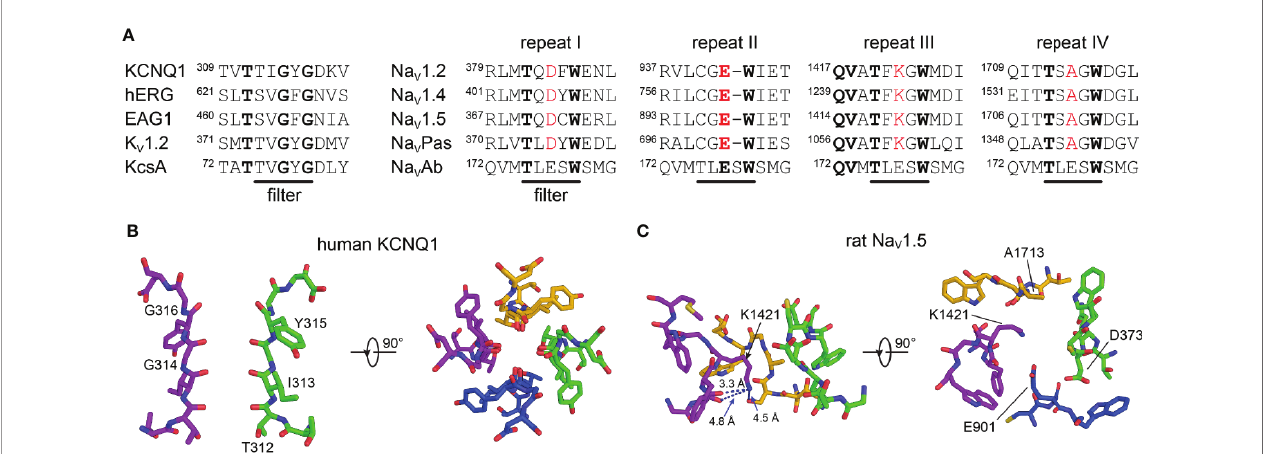
FIGURE 4 | The selectivity fi lters of K + and Na + channels. (A) Multiple sequence alignment of the SF region of selected K + (left) and Na + (right) channels. Conserved amino acids are highlighted in bold. Amino acids belonging to the DEKA signature motif in eukaryotic Na + channels are colored red. (B) Side and top view of the SF of human KCNQ1 (PDB: 6UZZ) (Sun and Mackinnon, 2020). Two subunits are omitted for clarity in the left plot. (C) Side and top view of the SF of SCN5A (PDB: 6UZ3) (Jiang et al., 2020). Repeat II is omitted for clarity in the left